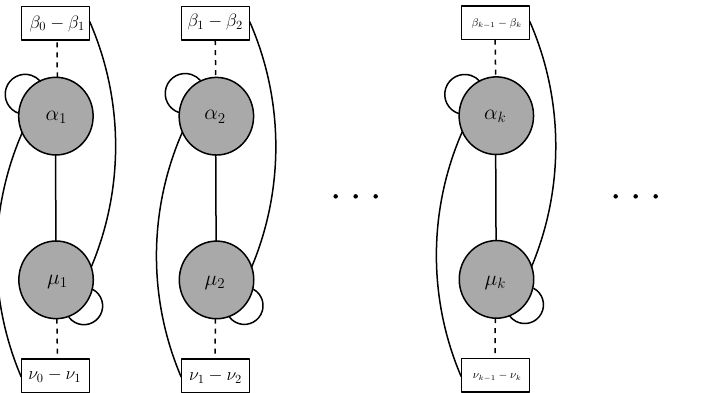
Figure 6. One-dimensional quiver field theory in which the IR limit is dual to the AdS 2 backgrounds reviewed in Section